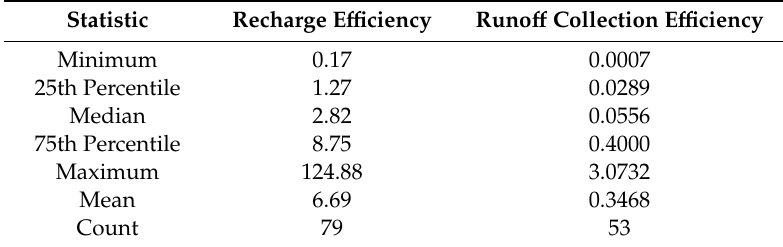
Table 2. Recharge e ffi ciency and runo ff collection e ffi ciency of the recharge dams